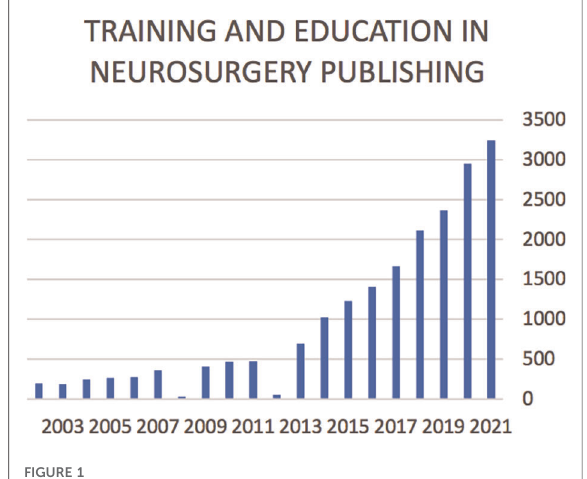
FIGURE 1 Number of publications about training and education in neurosurgery in the last two